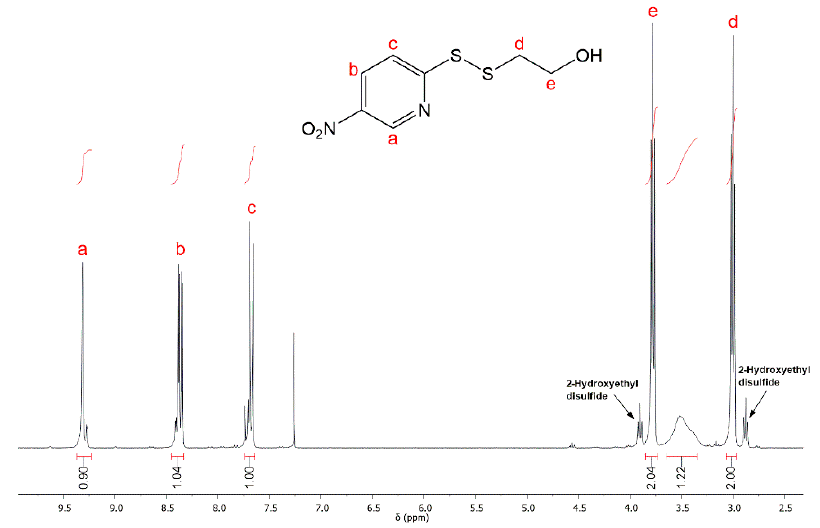
Figure 1. Synthesis of the amphiphilic redox-responsive poly(ethylene glycol)– block –poly(lactide) (PEG– block –PLA) in three steps.